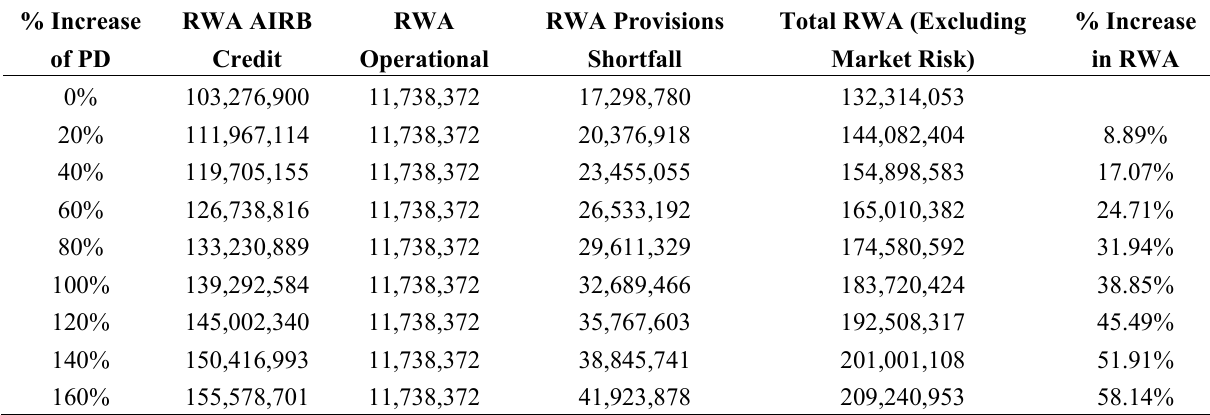
Table 3. Bank 1: stress scenarios for different levels of PD increases (th. EUR).